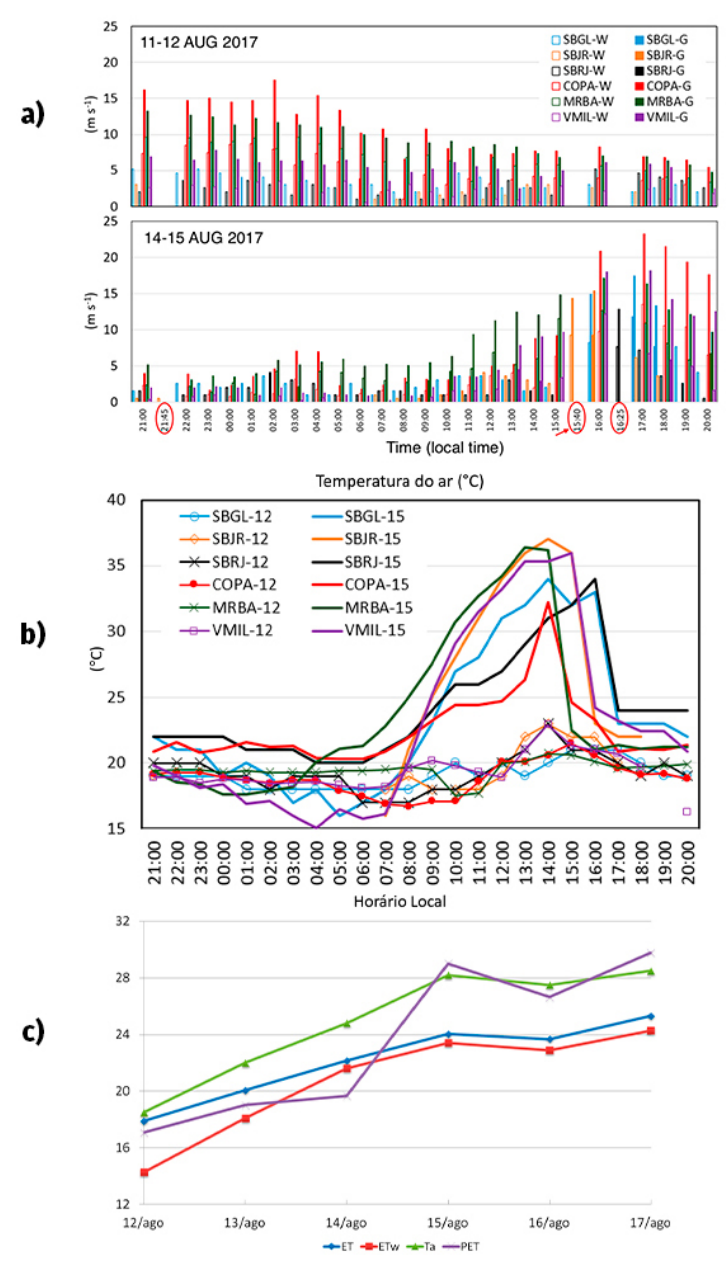
Figure 3. Hourly time series of INMET´s automatic weather stations (AWSs) and METAR observations